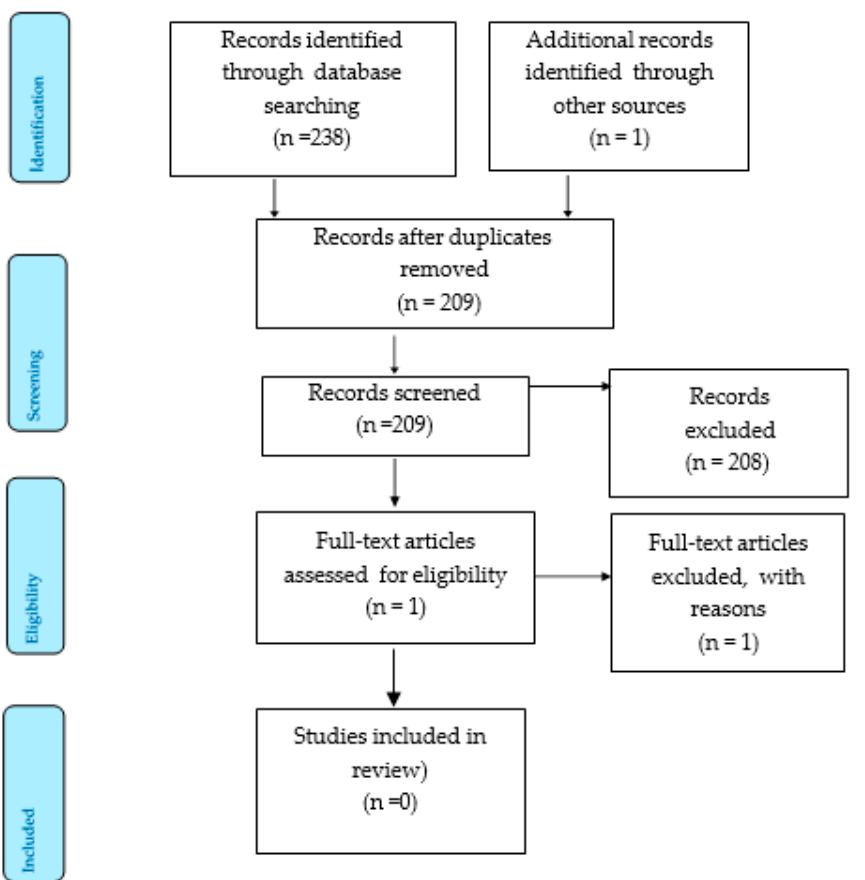
Figure 1. Preferred Reporting Items for Systematic Review and Meta-Analysis 2015.